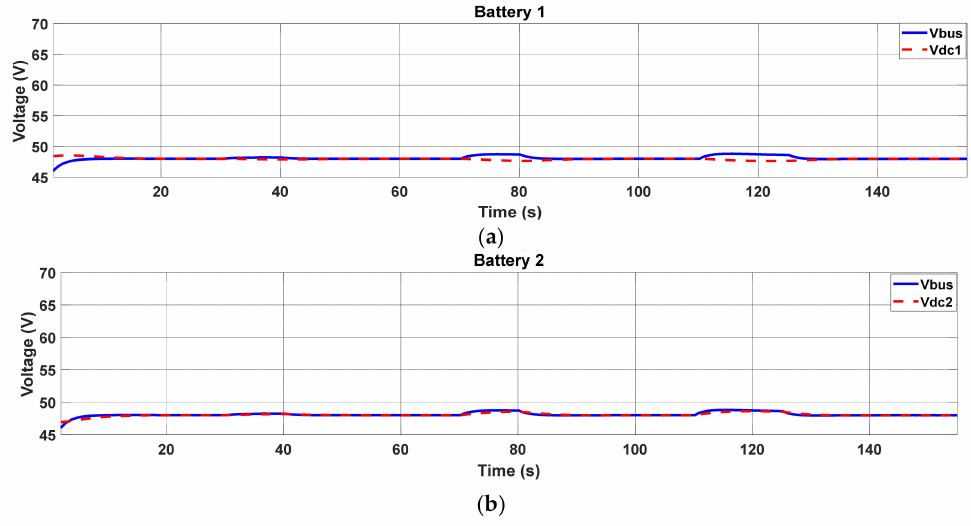
Figure 17. DC bus voltage control with distributed secondary control based on consensus algorithm for ( a ) battery 1 and ( b ) battery 2 in a time of 155